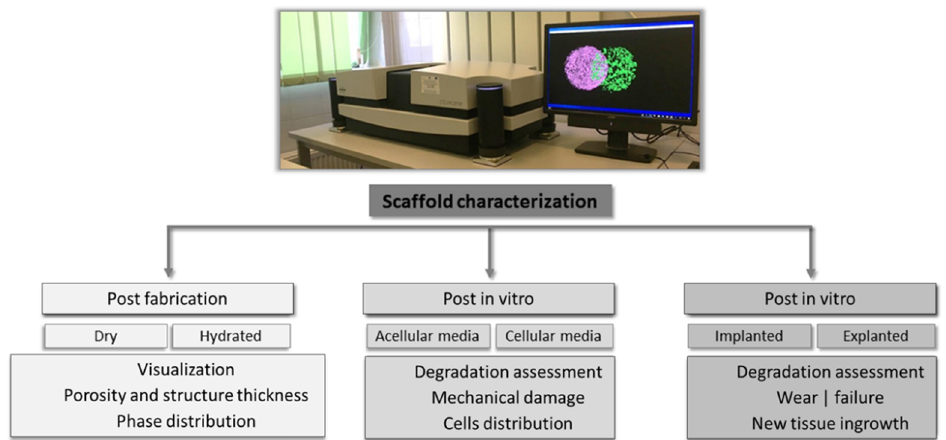
Figure 2. Types of scaffolds’ characterizations and corresponding assessments performed using CT